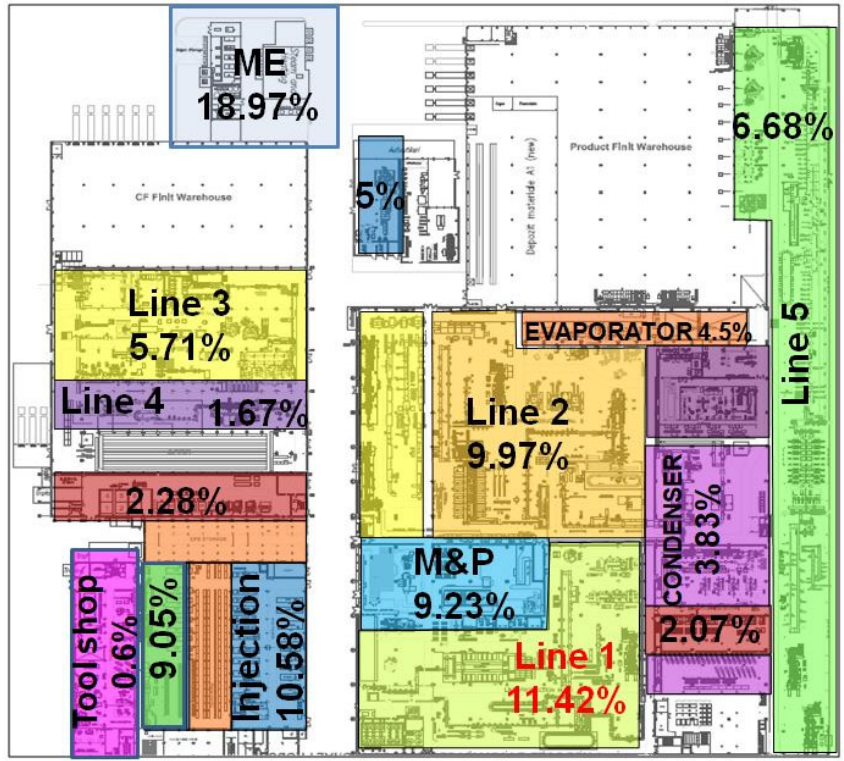
Figure 2. Electricity consumers map. ME—Maintenance Equipment. EPS—Expanded Polystyrene area. M&P—Mechanical and Painting area.